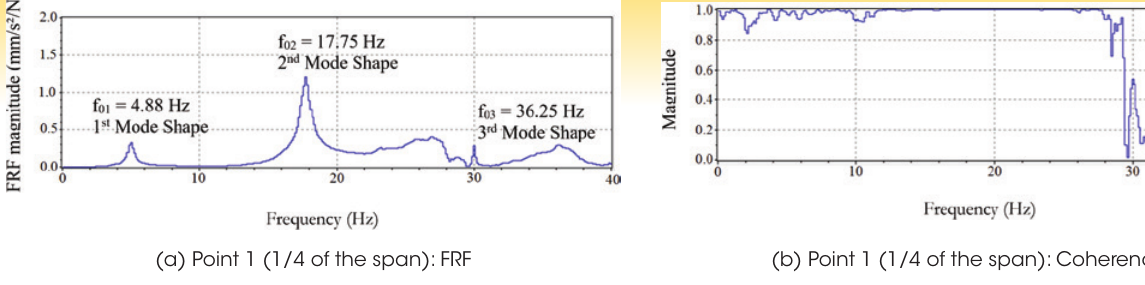
(b) Point 1 (1/4 of the span): Coherence